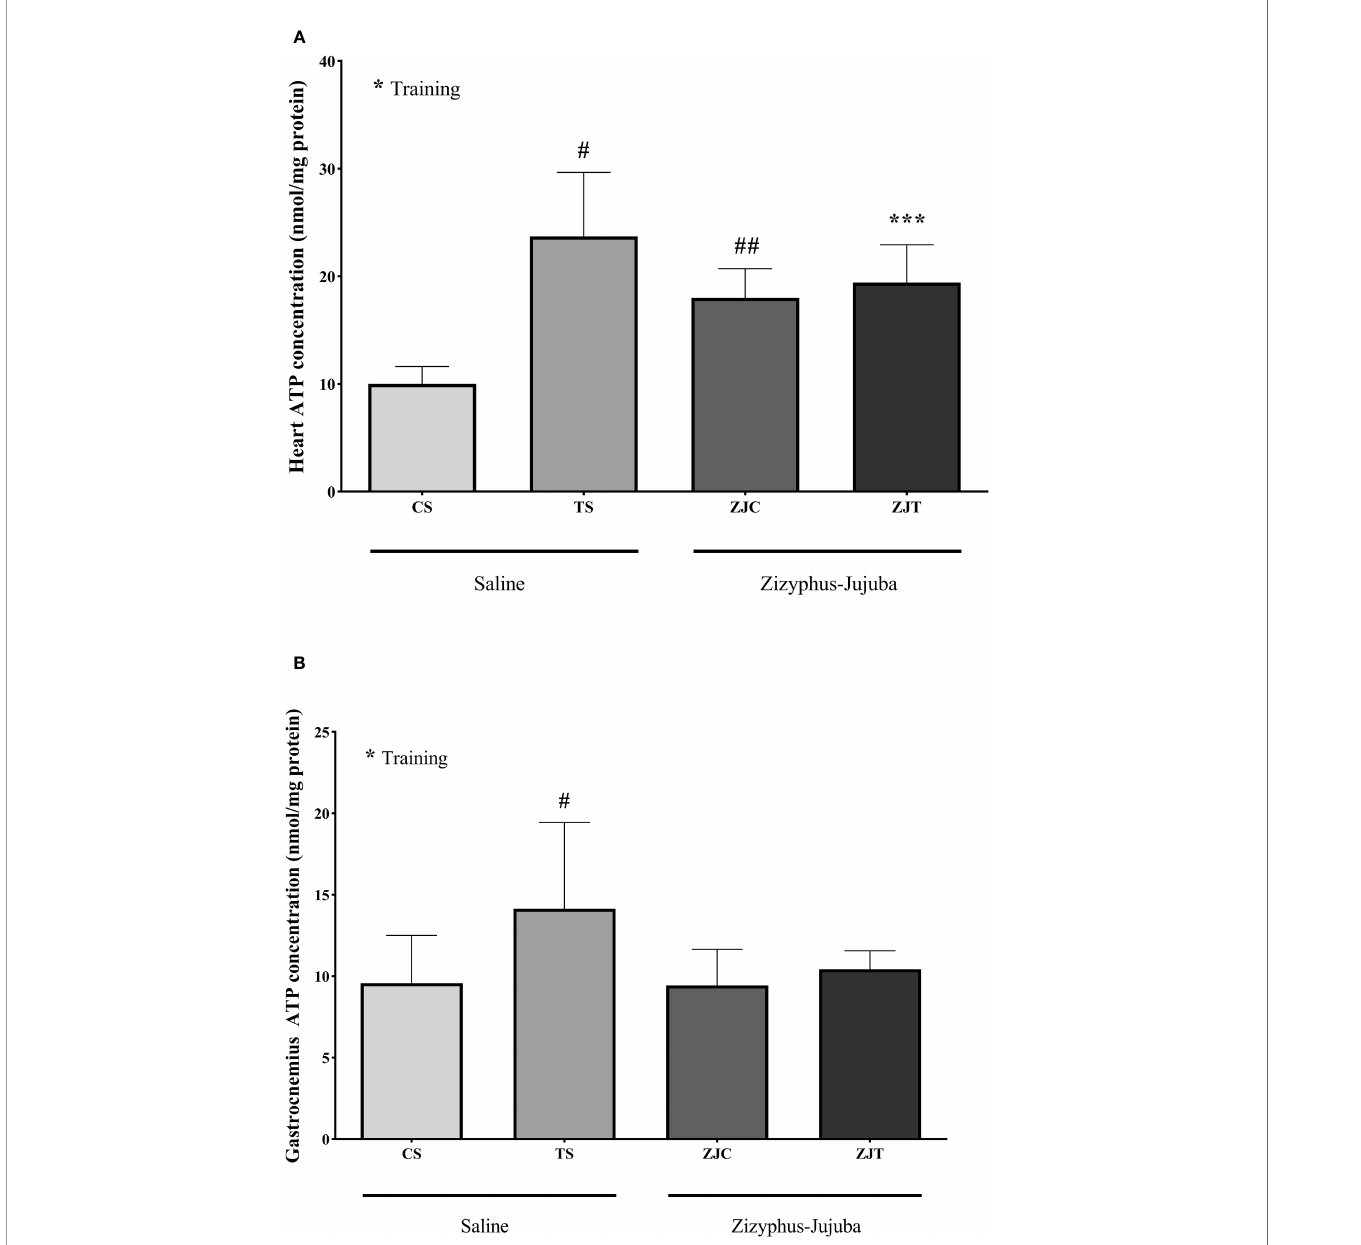
FIGURE 4 | Heart (A) and gastrocnemius (B) muscles ATP concentrations (nmol/mg) in Saline-Control (SC), Saline-High Intensity Training (ST), Ziziphus jujuba - Control (ZJC), and Ziziphus jujuba -High Intensity Training (ZJT) groups. Data were expressed mean ± SD, P value set at < 0.05, and 7 rats per each group. * Training main effect (P=0.015 and P=0.013 for heart and gastrocnemius respectively), *** Training and Ziziphus jujuba interaction (P=0.05 for heart), # TS than CS (P=0.004 and P=0.01 for heart and gastrocnemius respectively), ## ZJC than CS (P=0.047 for